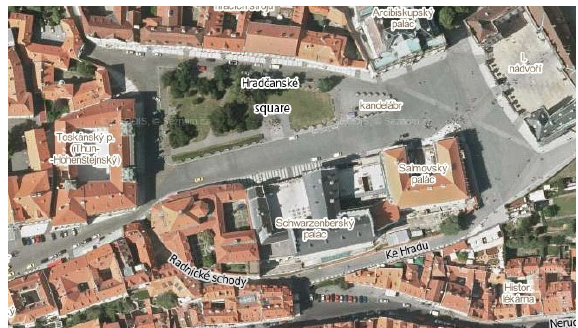
Figure 4. Location of the monastery on a steep south side of the castle promontory between Prague Castle Square and Radniční schody (Town Hall Stairs).